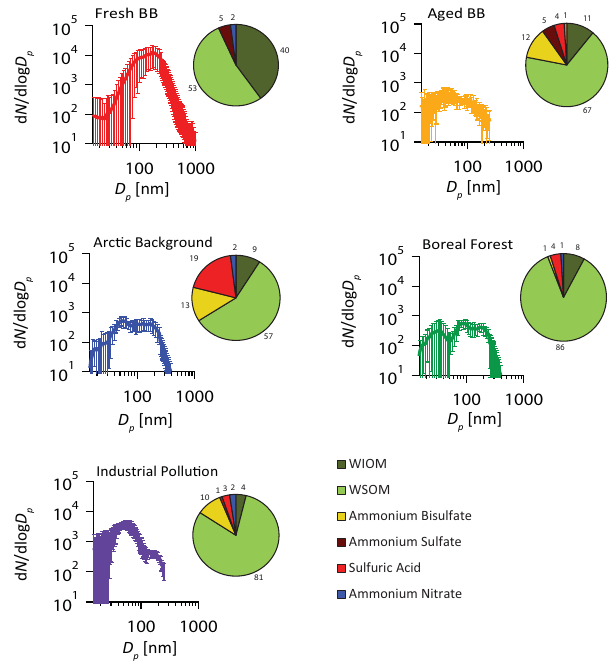
Fig. 2. Average dry particle size distributions (d N/ dlog D p ) for each air mass source type and average aerosol volume fractions (%) calculated from the HR-TOF-AMS and PILS-WSOC mass load- ings (inset). Water-soluble organic matter (WSOM) is calculated from PIL-WSOC (Sect. 2.3), and water-insoluble organic matter (WIOM) is taken as the difference between WSOM and total or- ganic carbon measured by the HR-TOF-AMS. Error bars on size distributions denote one standard deviation from the